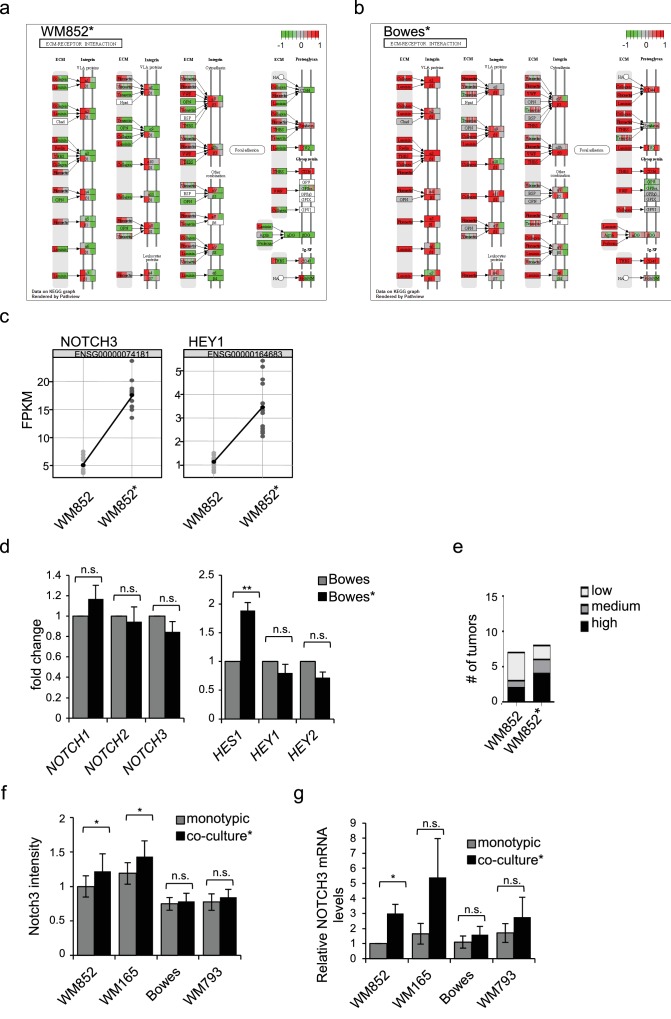
LEC priming induced differential changes in the ECM-receptor interaction pathway and Notch signaling pathway.(a–b) ECM-receptor interaction (hsa04512) KEGG pathway map rendered with Pathview from RNA-seq data described in Figure 2 of (a) WM852* and (b) Bowes* cells. Red represents upregulated and green downregulated genes in WM852* and Bowes*. (c) FKPM values of NOTCH3 and HEY1 gene expression in WM852* cells in RNA sequencing analysis in Figure 2A. A dot represents one replicate. (d) mRNA fold change of the indicated targets in Bowes and Bowes*. Average from three independent experiments is shown. **: p<0.001; n.s., non-significant. (e) Quantification of Notch3 staining intensity in xenografts originating from WM852 (n = 7) or WM852* (n = 8). (f) Quantification of Notch3 signal intensity for the indicated cell lines. Average of the intensity was calculated in four images/condition (from two independent experiments. More than 100 cells were always analysed per condition. Error bars indicate SD. *:p<0.05; n.s., non-significant. (g) NOTCH3 mRNA fold change in the indicated melanoma cell lines from monotypic culture or co-cultured with LEC (*). Data averaged from four independent experiments is shown. *:p<0.05; n.s., non-significant.